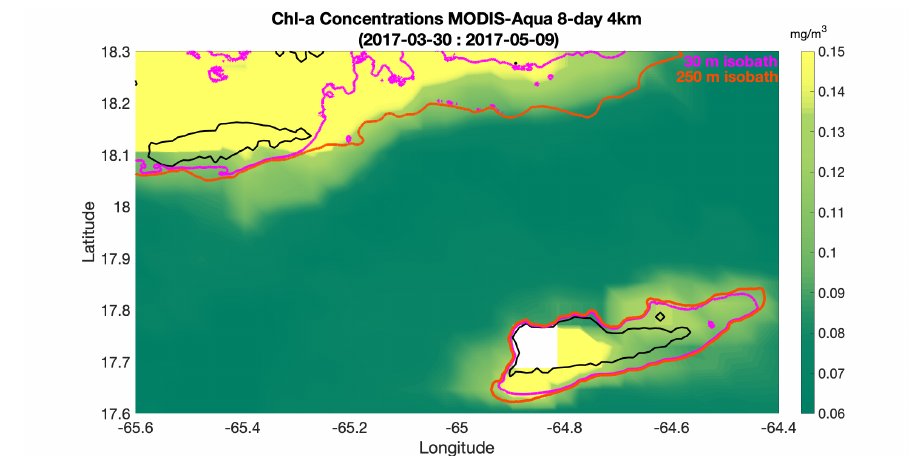
Figure 10. Satellite derived Chl-a concentrations from 30 March to 9 May 2017. Data obtained from the NASA GES DISC GIOVANNI tool